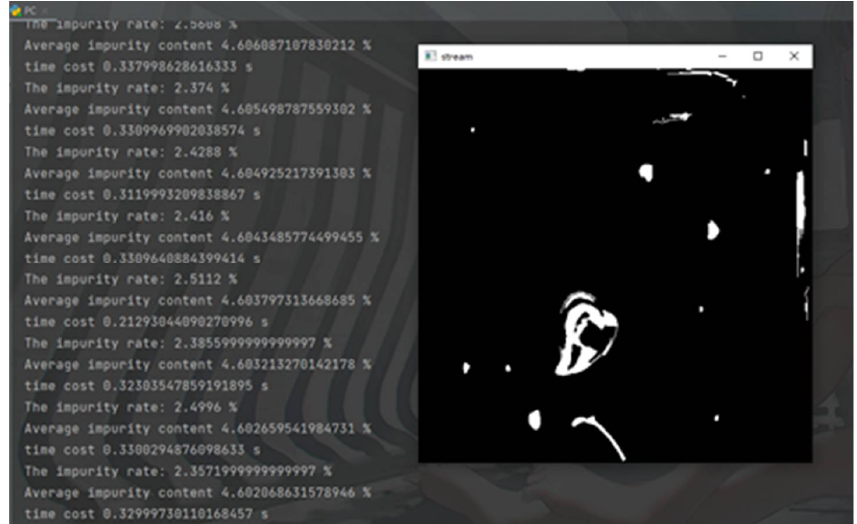
Figure 3. Real-time processing results of upper computer.